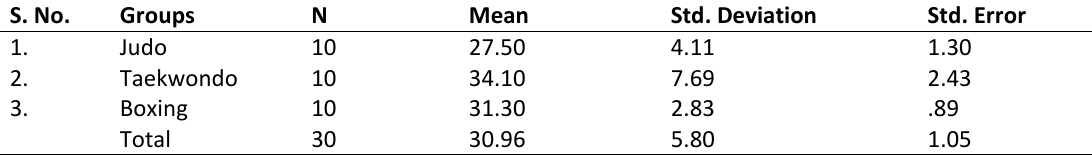
Table 1. Descriptive analysis among Judo, Taekwondo and Boxing on the sub-parameter clothing and appearance S. No.